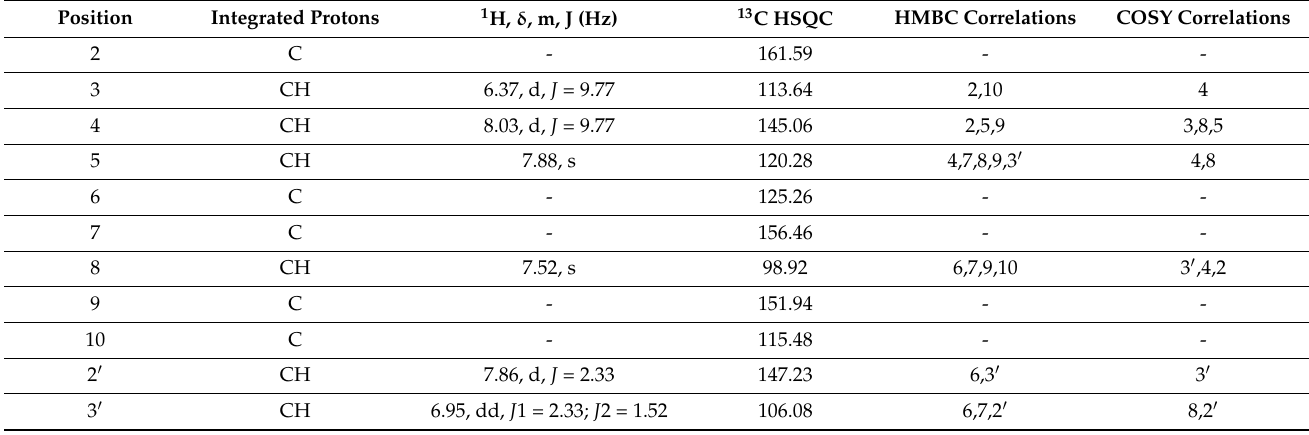
Table 2. NMR spectral references of